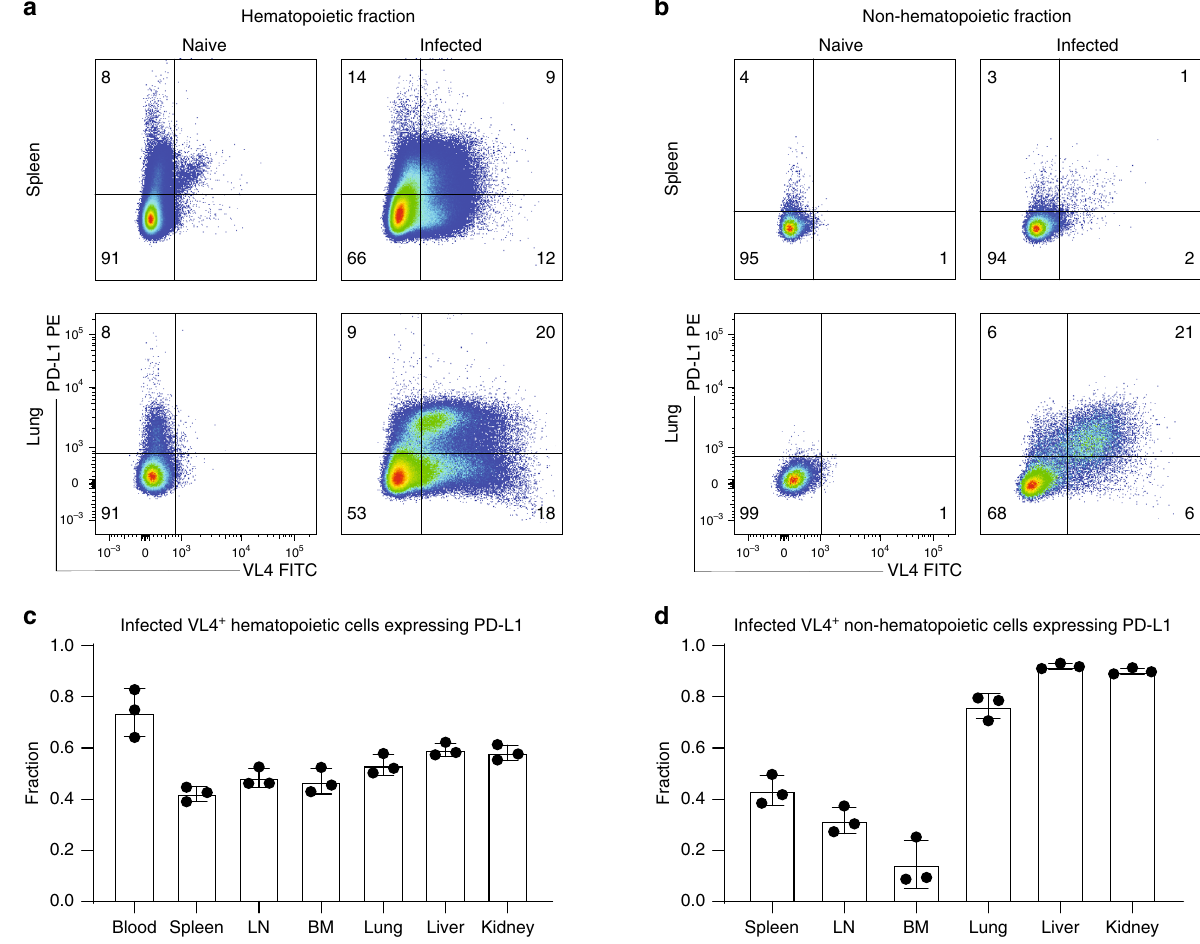
Fig. 5 PD-L1 expression on infected cells isolated 3 weeks into chronic infection. Seven tissues from chronically LCMV-infected mice were analyzed for infected (VL4 + ) cells 21 days post infection. Representative fl ow cytometry plots show PD-L1 and VL4 expression in hematopoietic (spleen) and peripheral tissues (lung) in the hematopoietic fraction a (gated on alive CD45 + CD45.2 + cells) or in the non-hematopoietic fraction b (gated on alive CD45 − CD45.2 − cells). Fraction of infected hematopoietic c or non-hematopoietic d cells (gated on VL4 + ) expressing PD-L1 is quanti fi ed in the bar plots showing mean ± SD. One of two experiments is shown ( n = 3 mice). Each dot represents an individual mouse. See also Supplementary Fig. 3. Source data are provided as a Source Data